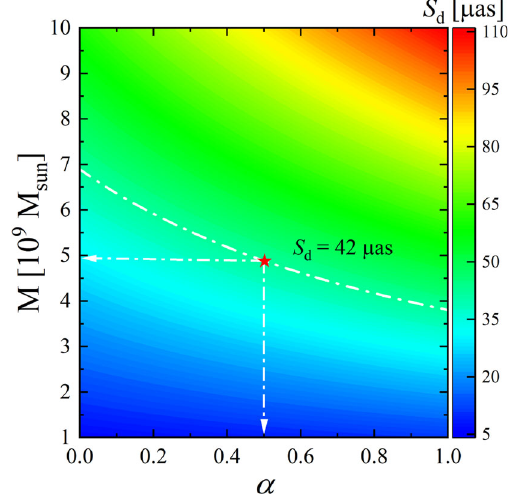
Fig. 14 The critical ring diameter S d of Schwarzschild-MOG BHs in the two-dimensional space of parameter α and mass M . Here the obser- vational angle and BH distance are fixed at 0 ◦ and 16 . 8 Mpc, respec- tively. It is clear that for a given BH mass and ring diameter, the grav- itational coupling parameter α of the Schwarzschild-MOG BH can be uniquely